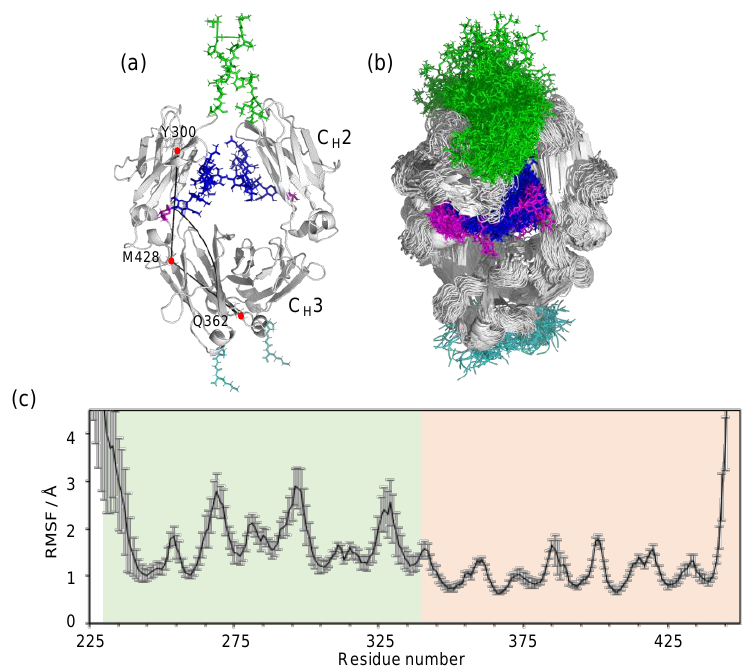
Figure 1. MD simulation of IgG1-Fc. ( a ) The starting structure of the MD simulation, based on the crystal structure of fucosyl IgG1-Fc (3AVE) supplemented with the hinge (green; T224–E233 in chain A and T224–G236 in chain B) and C-terminal (cyan; P445–K447) segments along with the terminal galactose residues (magenta) of the α 1-6Man branches. The N-glycans are colored blue except for the terminal galactose. The intra-chain domain-orientation angle between C H 2 and C H 3 defined by C α atoms of Y300, M428, and Q362 are shown in chain A. ( b ) The superposition of 256 structures extracted every 100 ns from the MD trajectory. The structures were visualized by PyMOL (https: // www.pymol.org). ( c ) The RMSF for each amino-acid C α atom of IgG1-Fc, which was calculated as described in Materials and Methods. White, hinge; light green, C H 2; light orange, C H 3.